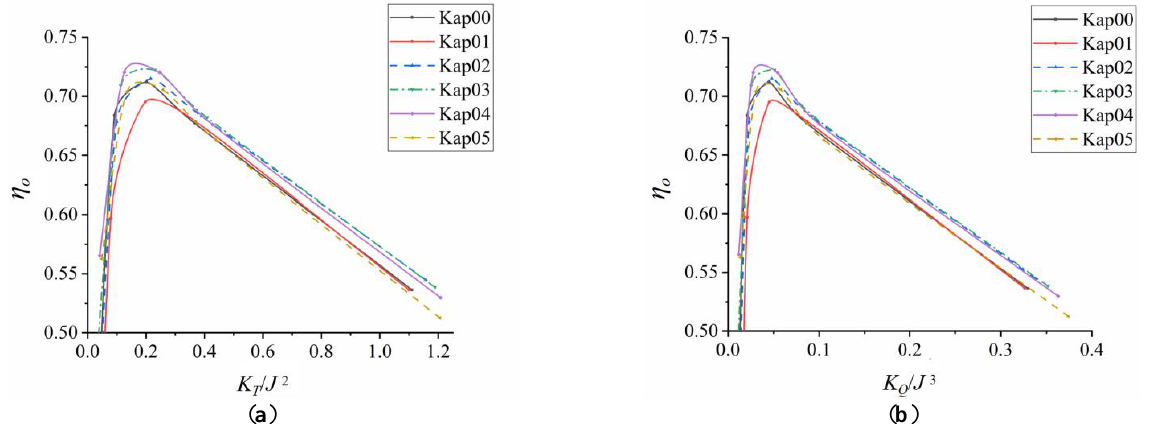
Figure 12. Relationship between efficiency of Kappel propellers and thrust load factor ( a ) together with power loading coefficient ( b ). with power loading coefficient ( b